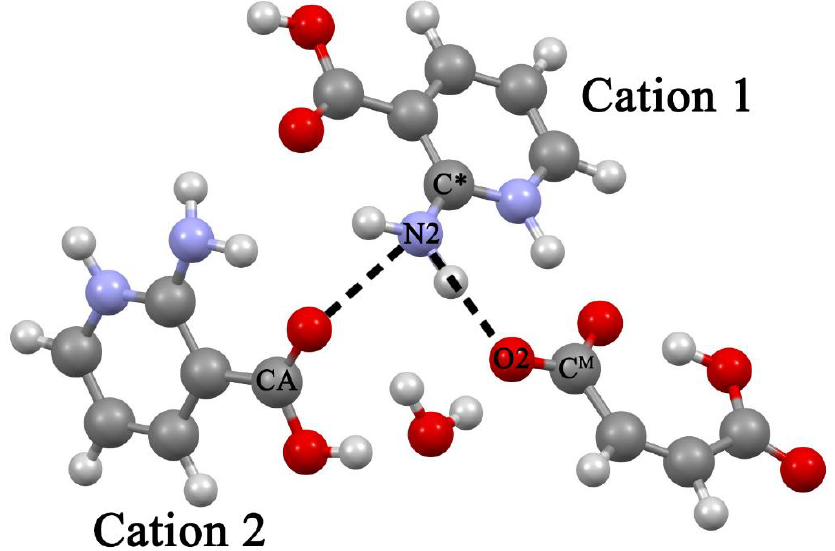
Figure 6. A fragment of the [2AmNic + Mle + H 2 O] (1:1:1) crystal structure. Black dotted lines indicate the N2 ··· O2 and N2 ··· O=CA distances.